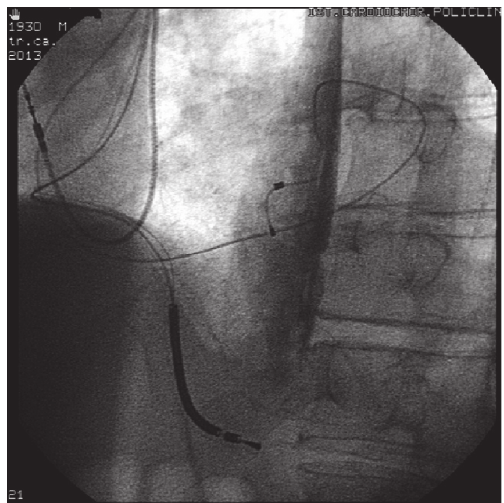
Figure 1: Fluoroscopy after inappropriate shocks.